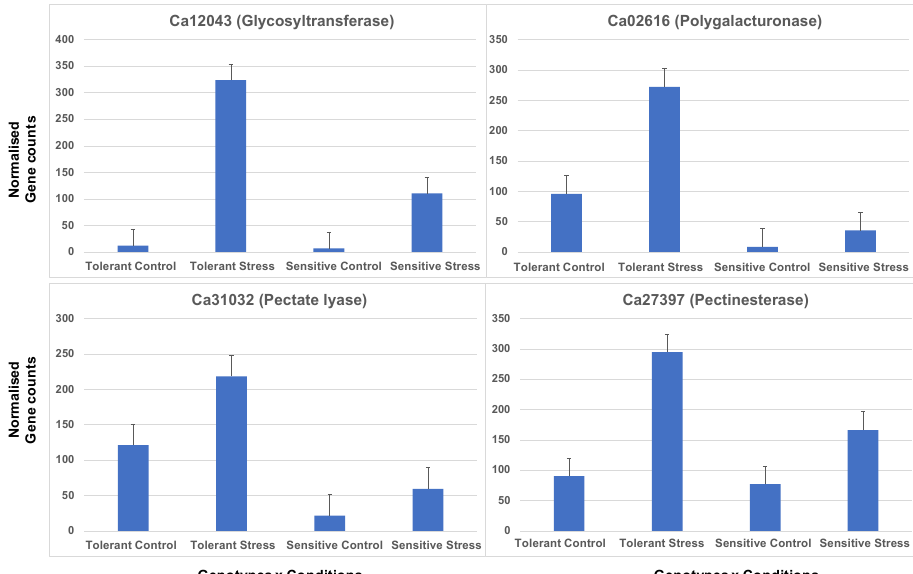
Figure 12. Differential expression of genes involved in cell wall biogenesis. Genes are induced in tolerant genotype stress conditions compared to sensitive genotypes in response to salt stress. The error bars are standard errors (SE) calculated using three biological replicates across the conditions.